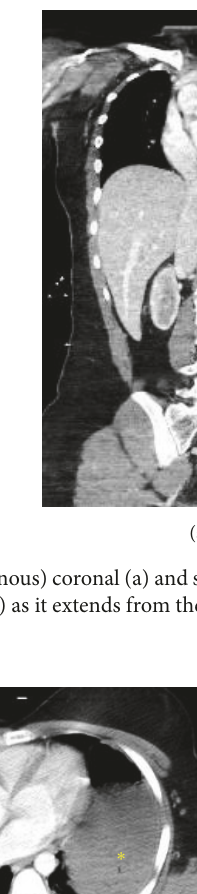
several pelvic bone fractures, left sacroiliac joint diastasis, and a fracture of the left sacral